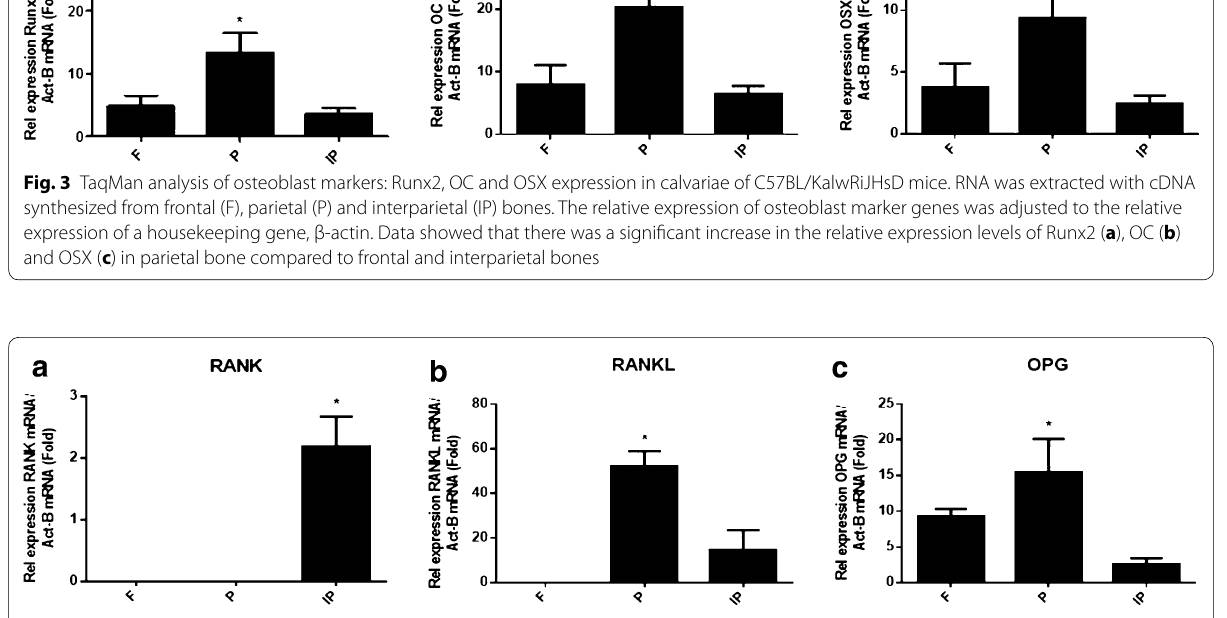
Fig. 4 TaqMan analysis of bone resorption molecules: RANK, RANKL and OPG expression in calvariae of C57BL/KalwRiJHsD mice. RNA was extracted with cDNA synthesized from frontal (F), parietal (P) and interparietal (IP) bones. The relative expression of osteoclast marker genes was adjusted to the relative expression of a housekeeping gene, β‑actin. Data show that the RANK gene was only expressed in interparietal bone, while it was not expressed in frontal or parietal bones. Additionally, there was a significant increase in the relative expression of the RANK gene ( a ) in interparietal bone compared to frontal and parietal bones. On the other hand, there was a significant increase in the relative expression of the RANKL ( b ) and OPG ( c ) genes in parietal bone compared to frontal and interparietal bones